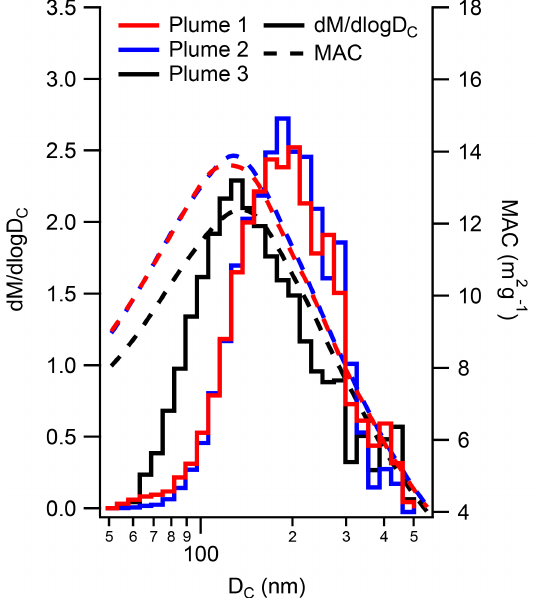
Figure 7. BC core size distributions measured by the SP2 and cal- culated size-dependent MAC for the three plumes, calculated us- ing n core = ( 1 . 85 − 0 . 71 i) and assuming a constant distribution of shell/core